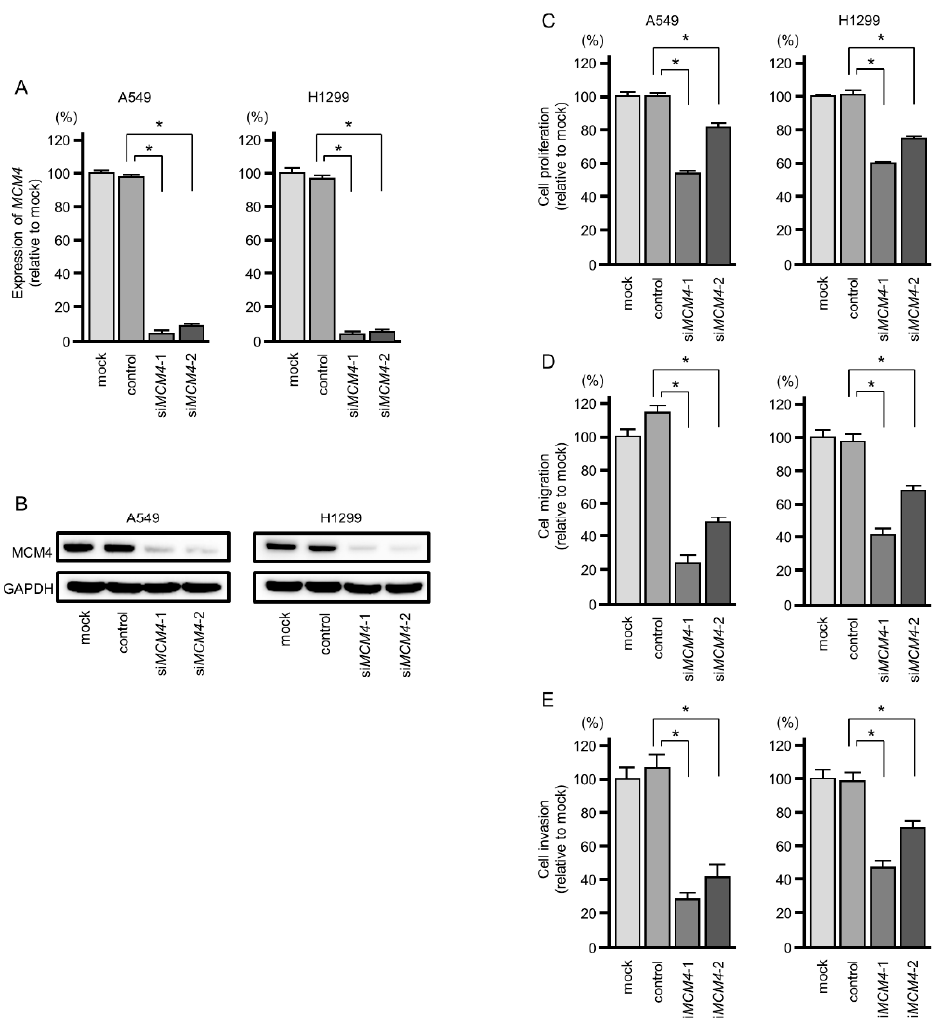
Figure 8. E ff ects of MCM4 silencing on cell proliferation, migration, and invasion in LUAD cells. ( A , B ) The e ff ects of si MCM4 in LUAD cells. MCM4 mRNA and protein expression levels were significantly reduced by si MCM4 transfection into A549 and H1299 cells (72 h after transfection). Expression of GAPDH / GAPDH was used as an internal control. ( C ) Cell proliferation activities were blocked by si MCM4 transfection into LUAD cells. ( D , E ) Cell migration and invasive abilities were blocked by si MCM4 transfection into LUAD cells (* p < 0.001).